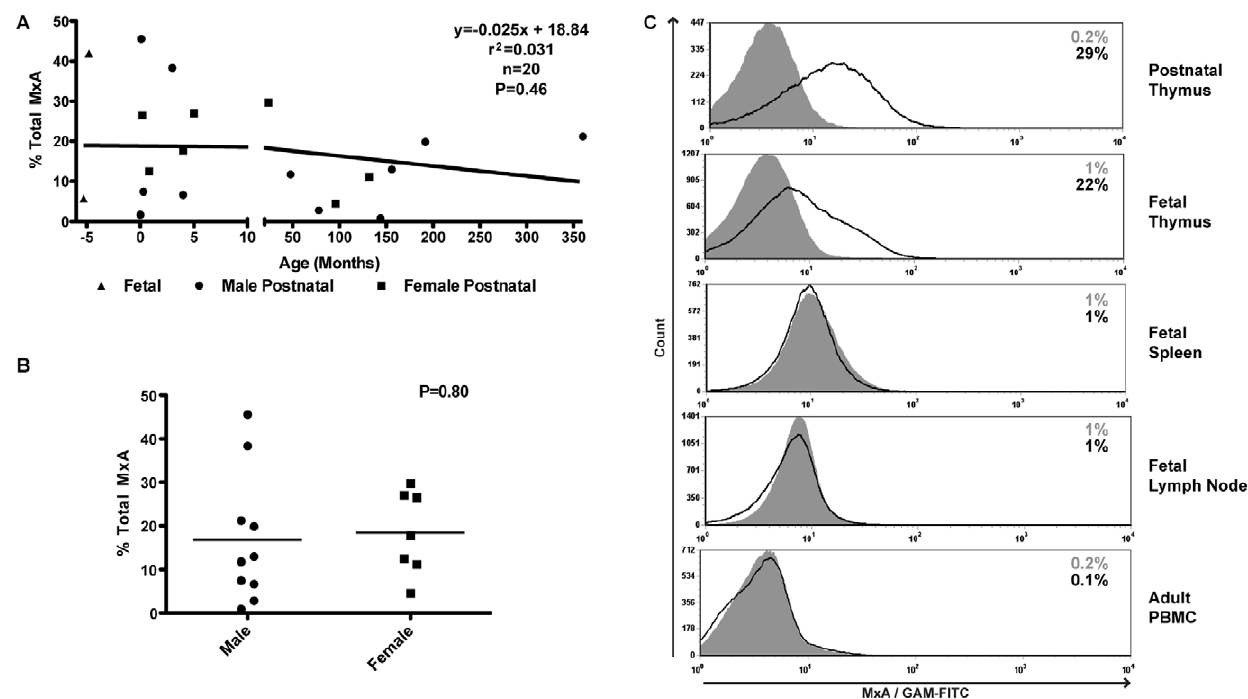
Figure 1. Constitutive expression of MxA in thymocytes. A,B , Total thymocytes were isolated from fetal and postnatal thymus tissues. Cells were stained for surface expression of CD3, CD4, CD8 and intracellular expression of MxA ex vivo . Three fetal and 18 postnatal thymus tissues were examined to determine the effect of age (A) and sex (B) on MxA expression. C , Cells from postnatal thymus, fetal thymus spleen and lymph node tissues and adult PBMC were stained for intracellular expression of MxA. Fetal tissues were obtained from the same donor.